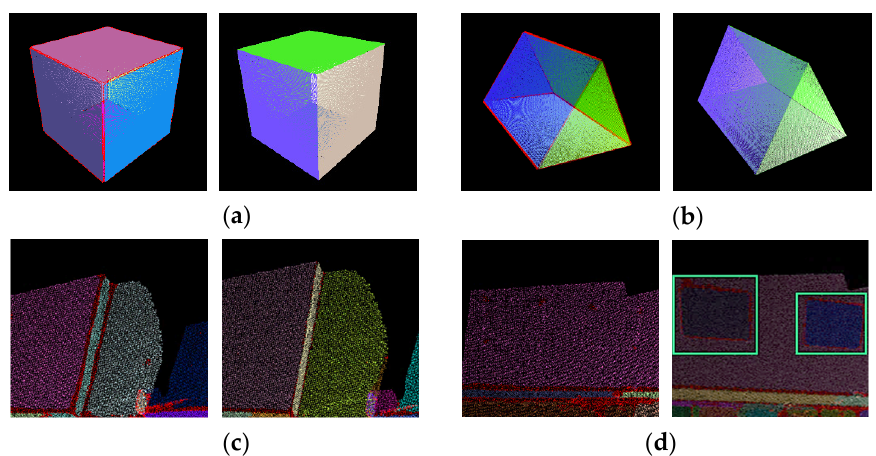
Figure 23. Comparison of plane segmentation: ( a ) simulation dataset 1, ( b ) simulation dataset 2, and ( c,d ) part of real dataset 1. Red points mean unclassified points. Other color points mean different planes. In each panel, the left image is the result from traditional region growing (TRG) and the right image is the result from our method.